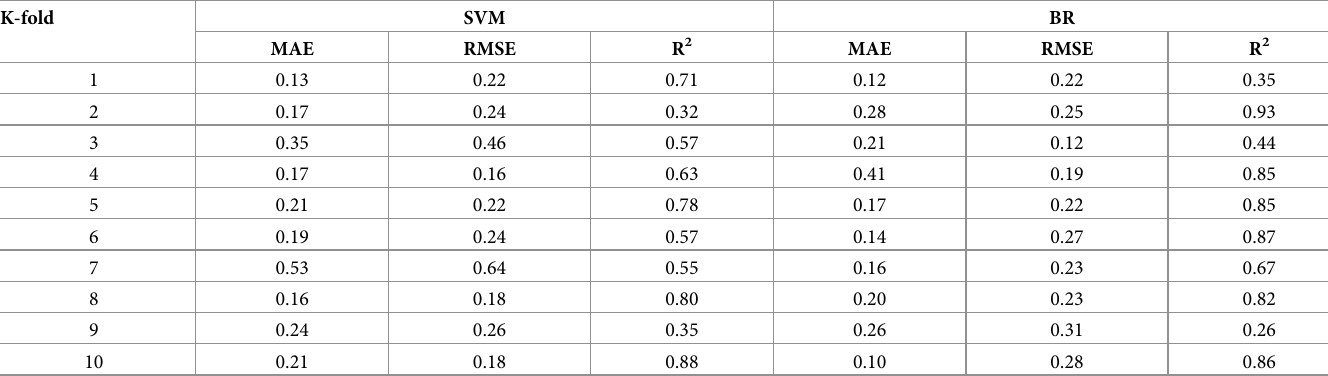
Table 3. Results of k-fold evaluation for the employed ML models.